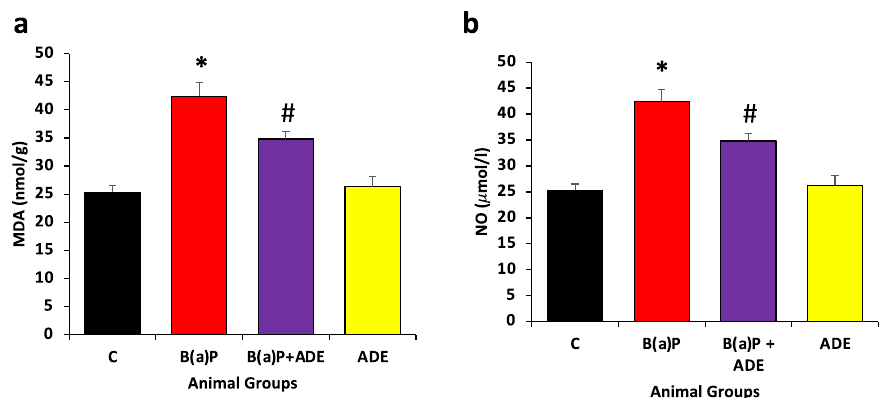
Figure 2. Effect of ADE on ( a ) MDA and ( b ) NO level in different treatment animal groups. MDA and NO were meaningfully increased in the B(a)P-treated group. The MDA and NO levels significantly decreased in the ADE treatment group. The number signifies the mean ± SEM with 8 animals per group. The statistical differences are represented with an asterisk (*) representing significance at ( p < 0.05) as compared to the normal control group and hash (#) represents ( p < 0.05) when compared with B(a)P-treated group only.